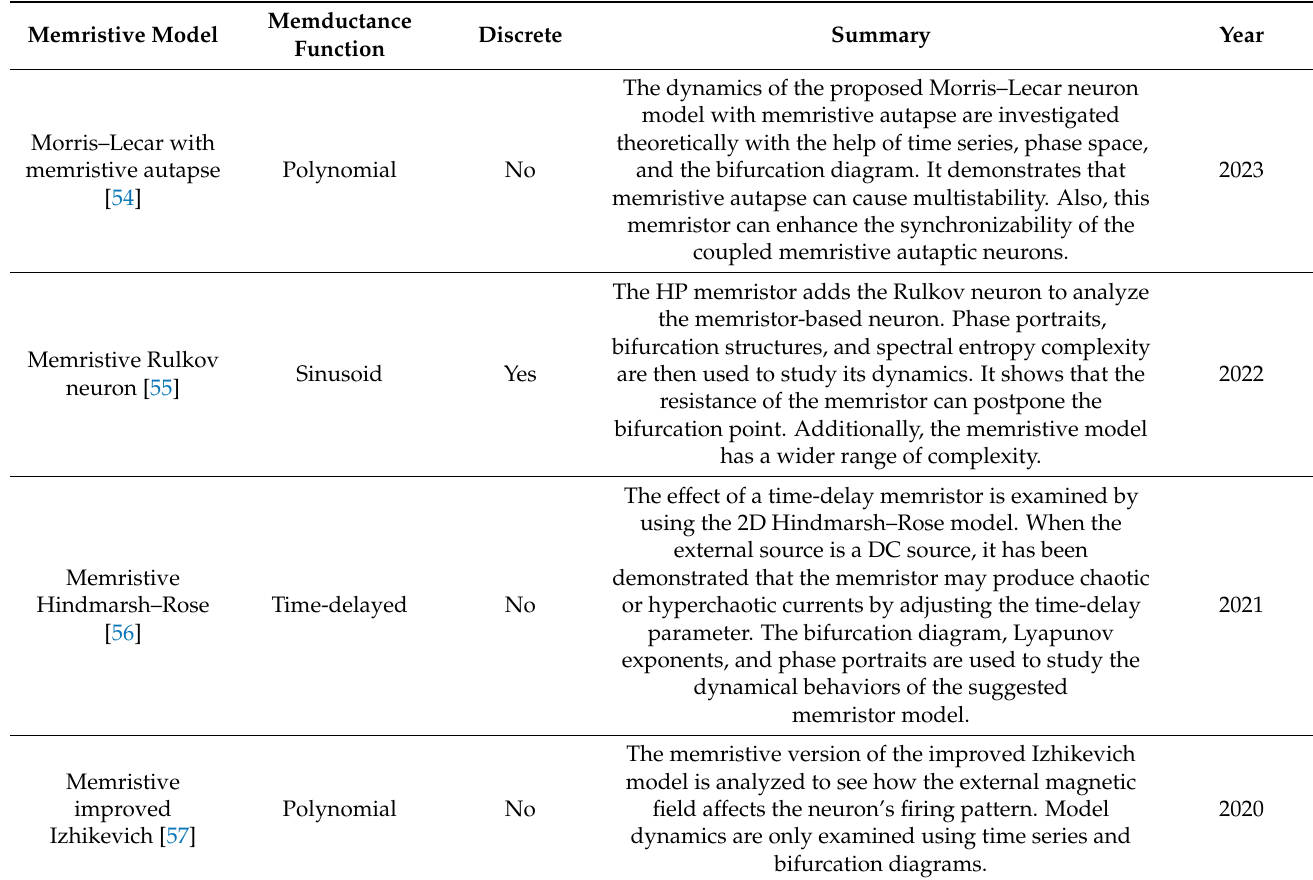
Table 2. Comparison of the proposed model with some other memristive neuron models.